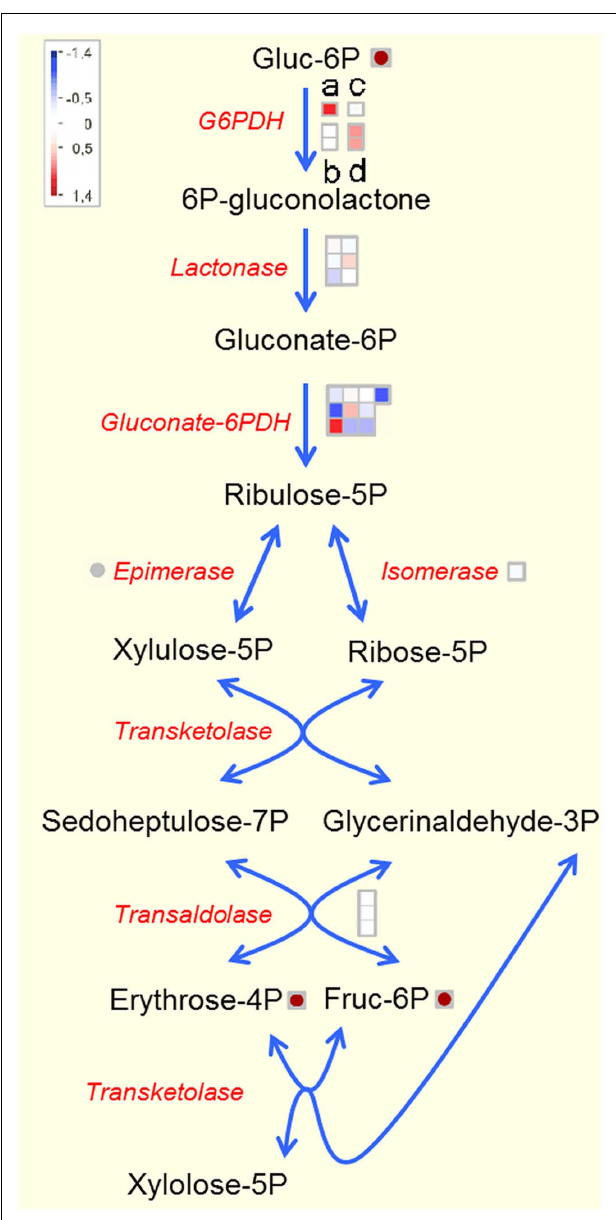
FIGURE 9 | Pentose phosphate pathway in U-IN-2. (a–d) Differentially expressed isoforms of G6PDH. (a) and (d) are plastidial isoforms.